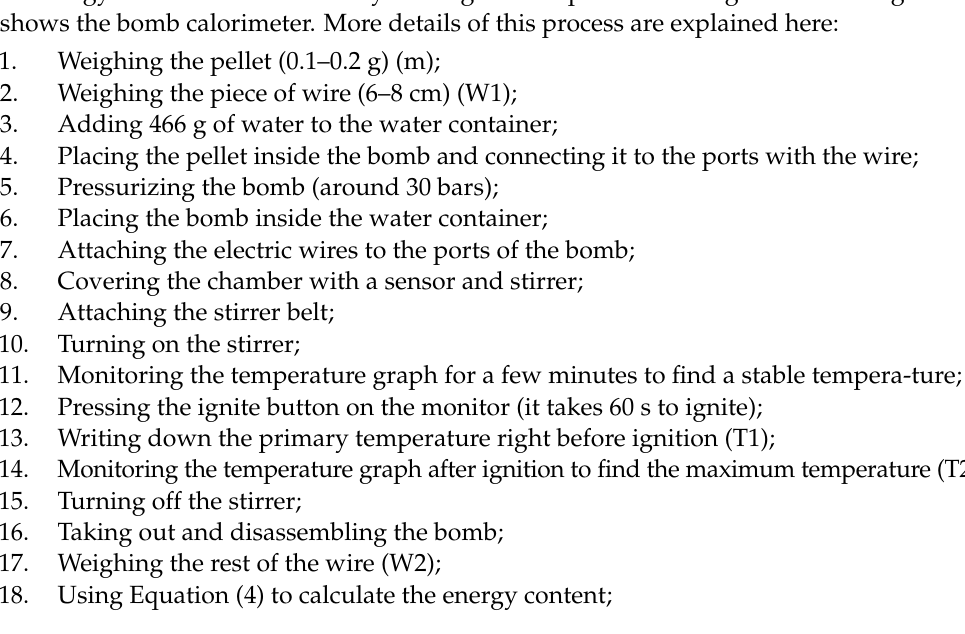
Figure A3. A mixture of seaweed, sawdust, and hay.